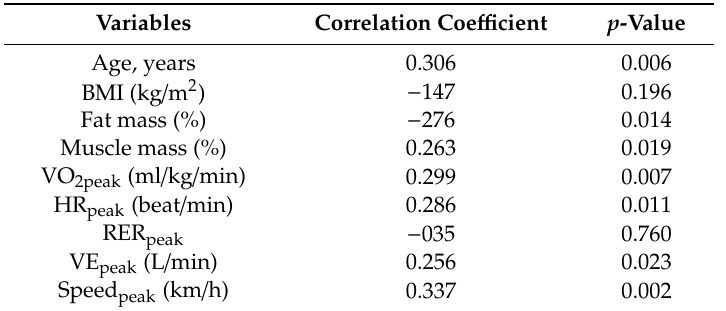
Table 3. Correlation Coe ffi cients and p -values among Tsk peak and Age, BMI, Fat mass %, Muscle mass %, VO 2peak , HR peak , RER peak , VE peak and Speed peak . Variables Correlation Coe ffi cient p -Value Age, years 0.306 0.006 BMI (kg / m 2 ) − 147 0.196 Fat mass (%) − 276 0.014 Muscle mass (%) 0.263 0.019 VO 2peak (ml / kg / min) 0.299 0.007 HR peak (beat / min) 0.286